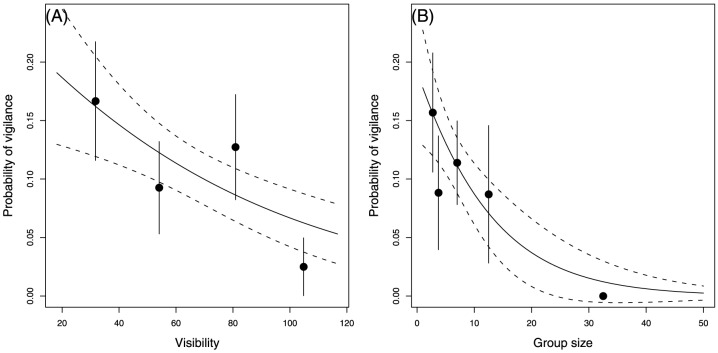
Representation of the covariates ([A]: visibility; [B]: group size) selected in the best logistic model explaining adult female vigilance (Table 3).The fitted logistic models (black lines) as well as their standard errors (dashed lines) were shown. Black circles corresponded to observed proportion (±SE) for a given class of the covariates (sample sizes of classes ranged from 40 to 55 for the covariate “visibility” and from 16 to 79 for the covariate “group size”). The predicted probabilities were associated with the level of “females with lamb” and “no WR”, and for the average group size (A) or the average visibility (B). Observed proportions were computed from a subset of the data including adult females with lamb observed outside the WR, and for the full ranges of group size (A) and habitat visibility values (B).